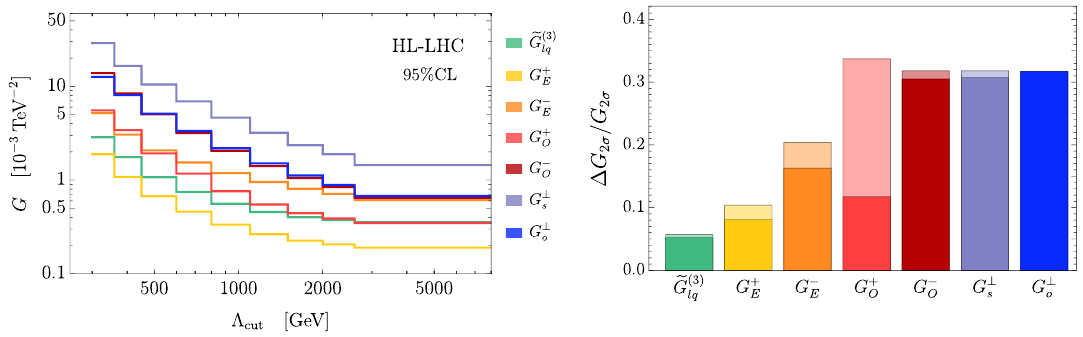
Figure 5 . Left panel: expected bounds on the Wilson coefficients as a function of the upper cut on the energy of the events Λ cut . Right panel: relative change in the bounds in the last two bins in Λ cut . The darker shadowing corresponds to the fully-differential analysis, while the lighter shadowing corresponds to the single diff.